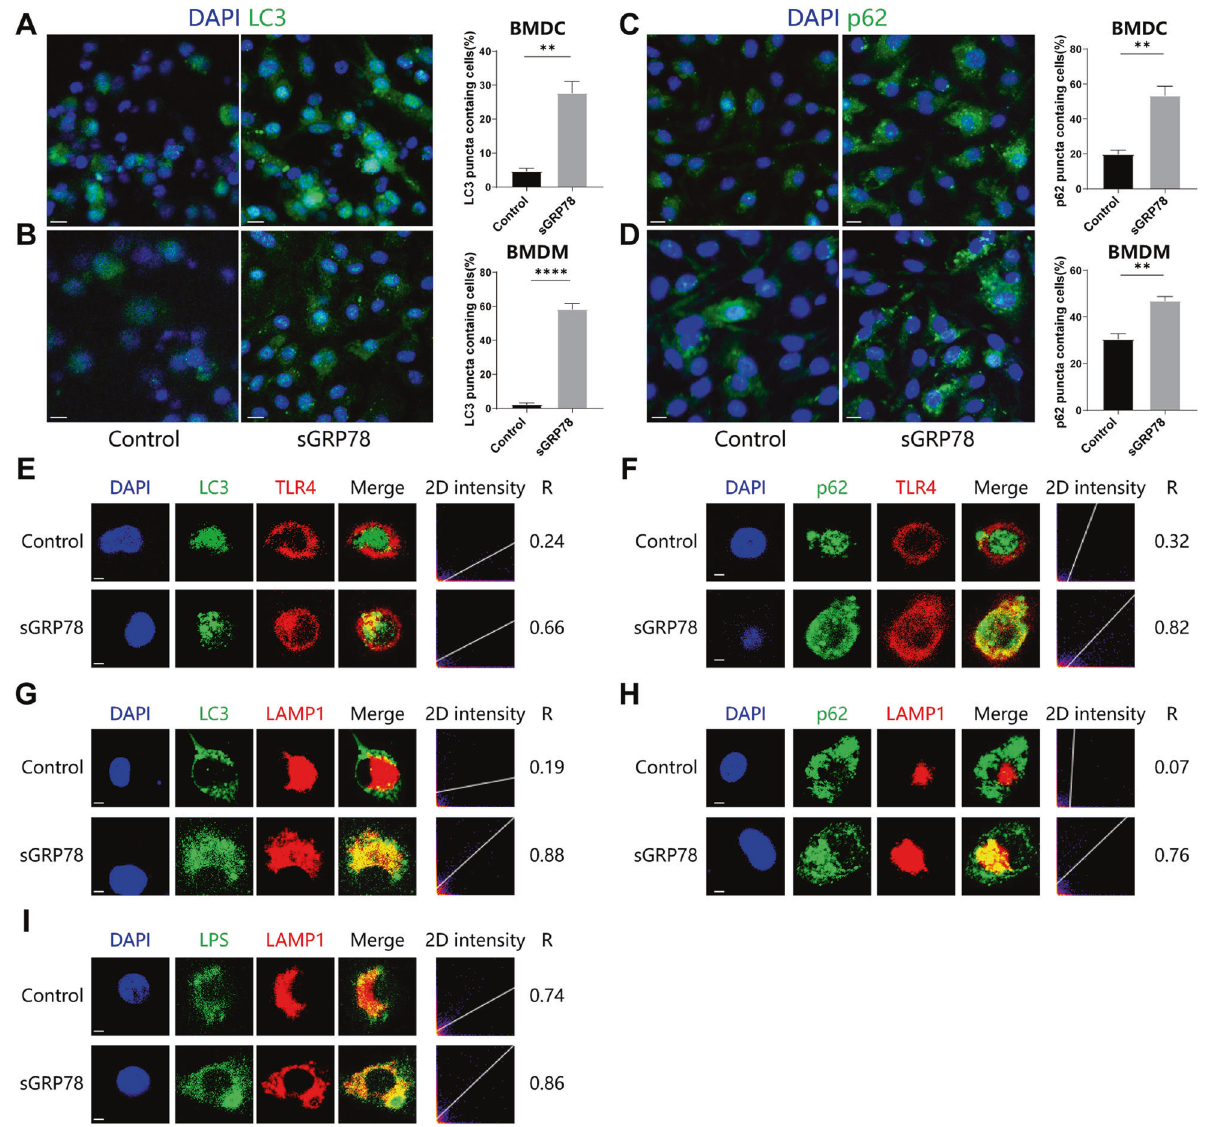
Fig. 5 sGRP78 promotes autophagosome formation in myeloid cells. A – D 12 h after sGRP78 treatment, BMDCs ( A, C ) and BMDMs ( B , D ) were immunolabeled with LC3 ( A , B ) and p62 ( C , D ) antibody. BMDCs ( E – H ) or FITC-LPS-treated BMDCs ( I ) were incubated with sGRP78 for 1 h, followed by detection of intracellular LC3, p62, LPS, TLR4, and LAMP1. The colocalization between two markers was described by 2D intensity histogram and Pearson's R value. All images are representative of at least three independent experiments in which >100 cells were examined, and >95% of cells showed similar staining. Scale bar = 10 μ m ( A – D ) or 2 μ m ( E – H ). ** P < 0.01, **** P <